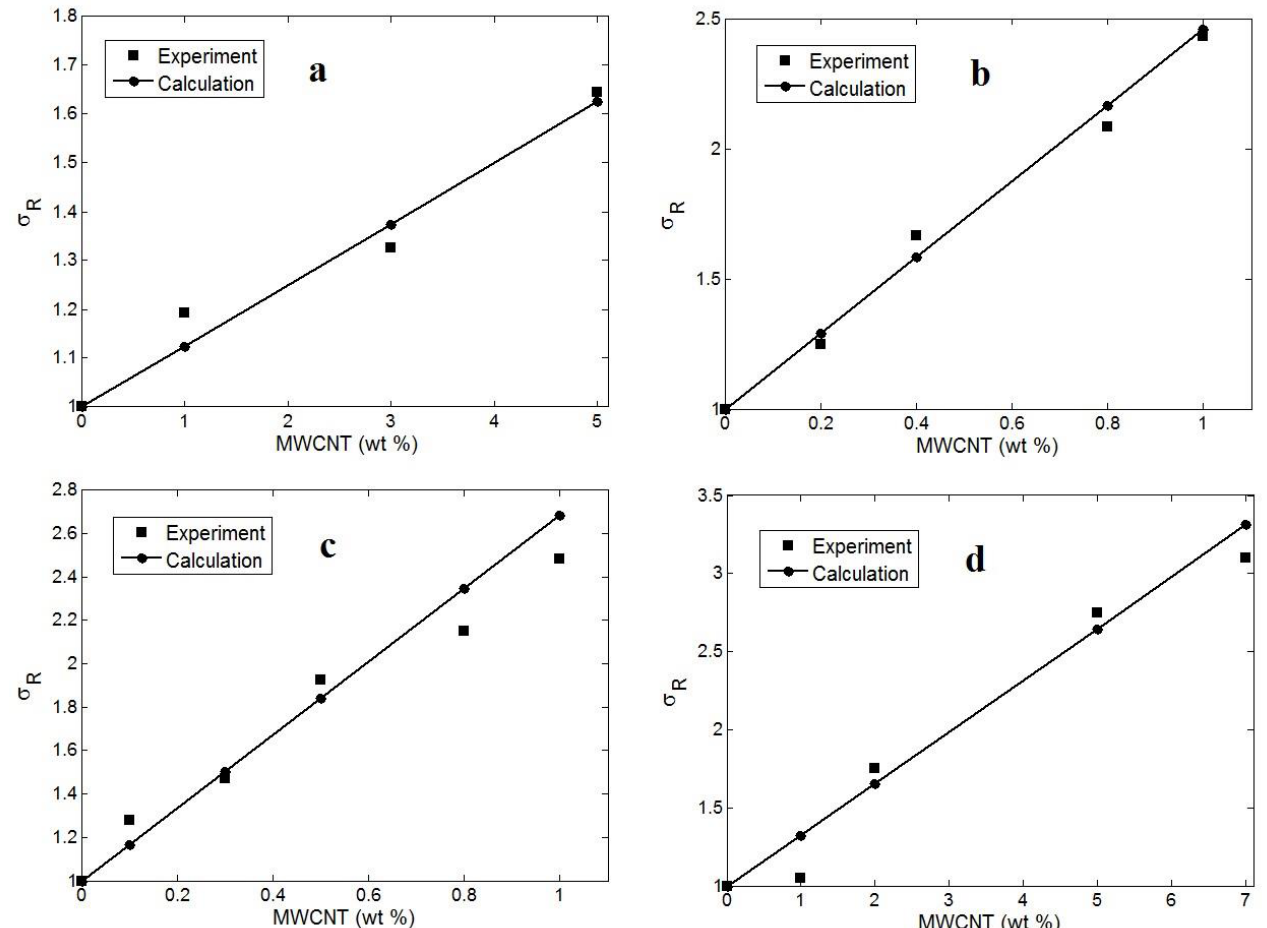
Figure 5. Comparison between the tentative and theoretical (Equation (17)) ranks of relative strength for ( a ) PVA/MWCNTs [54], ( b ) PSE/MWCNTs [55], ( c ) chitosan/MWCNTs [56] and ( d ) PPS/MWCNTs [57] systems.